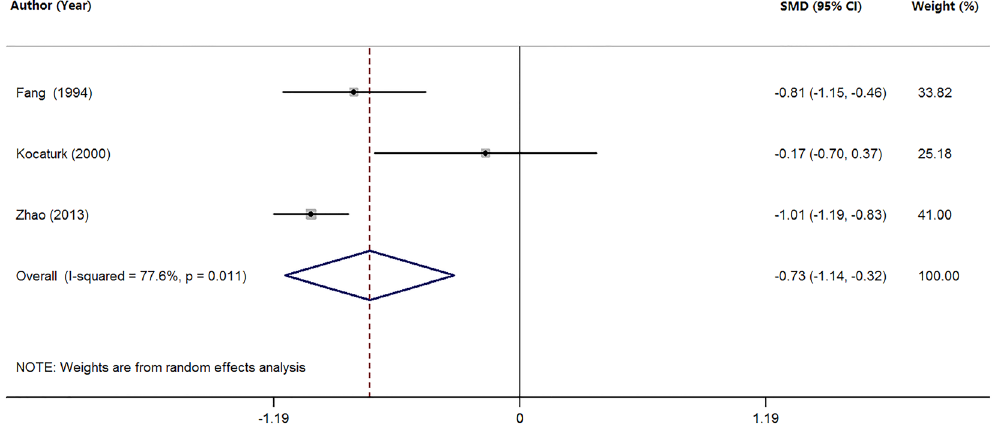
Figure 3. Forest plot for random-effects meta-analysis on differences in plasma Zn between PD patients and health controls. 3 studies encompassing a sample of 734 subjects. The horizontal lines represent 95% CI. The sizes of the shaded squares are proportional to study weight. SMD, Standardized mean difference; CI, confidence interval.